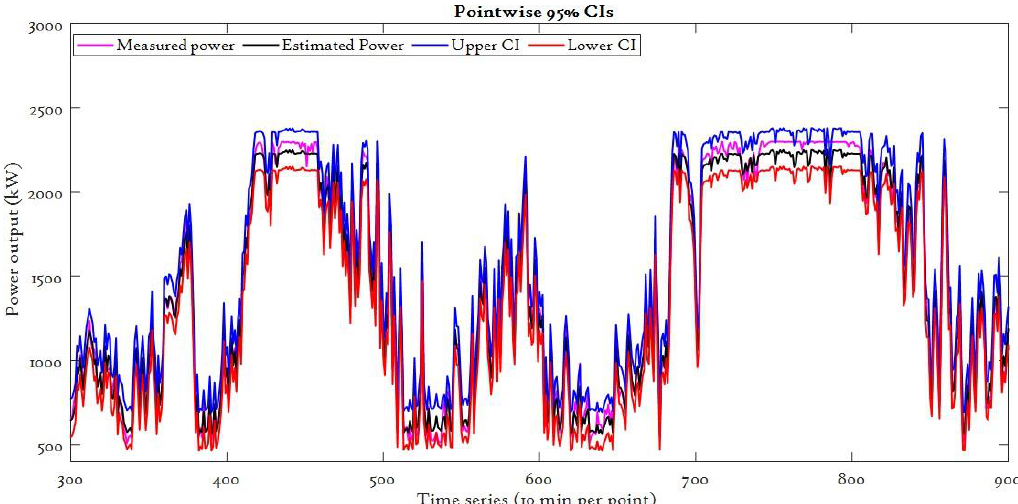
Figure 8. Analysis of pointwise CIs for estimated power values in time-series.